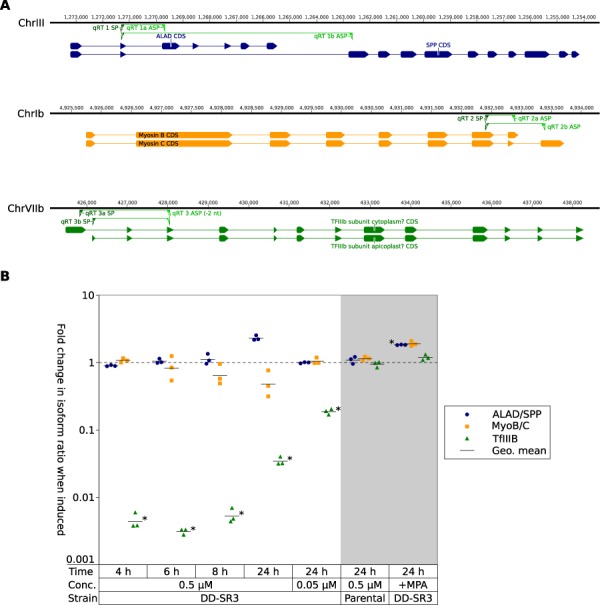
qRT-PCR of three known alternatively-spliced genes. (A) Schematic showing coding sequence of isoforms tested. Numbers on horizontal axis indicate position in the chromosome, as per ToxoDB (39). Solid blocks indicate exons, and joining lines indicate introns (untranslated regions not shown). Green triangles show primer-binding sites (the 3’ end of qRT 3 ASP binds on the other side of the intron). (B) Change in isoform ratio between isoform A and B (\documentclass[12pt]{minimal}
\usepackage{amsmath}
\usepackage{wasysym}
\usepackage{amsfonts}
\usepackage{amssymb}
\usepackage{amsbsy}
\usepackage{upgreek}
\usepackage{mathrsfs}
\setlength{\oddsidemargin}{-69pt}
\begin{document}
}{}$\Delta \mathrm{isoform\_ratio}$\end{document}) for these three genes, for different conditions as per the x-axis. The unshaded area represents addition of 0.5 µM Shld1 to the conditional mutant for 4, 6, 8 or 24 h; and addition of 0.05 µM Shld1 for 24 h. The shaded area represents controls: the parental strain with 0.5 µM Shld1 added for 24 h; and treatment of the mutant with 25 µg/ml mycophenolic acid (MPA) for 24 h. Horizontal lines show the geometric mean of triplicates. * indicates statistical significance with adjusted P value <0.05.